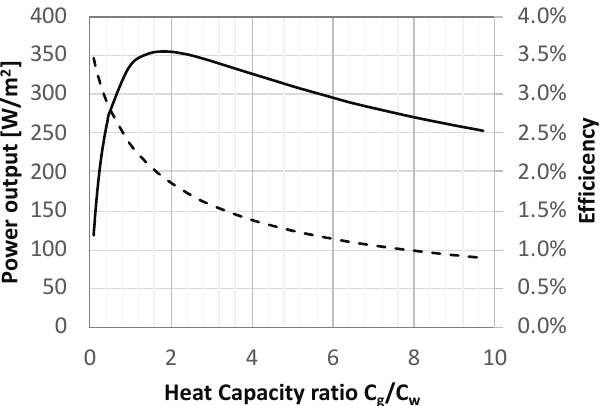
11 of 17 Figure 7. Energy harvesting efficiency as a function of heat capacity ratio, with a constant flow rate for water of 𝐶 (cid:3050) = 0.05 kg/s per unit footprint (1 m 2 ). This figure shows the maximum harvesting potential through the CHP system. TE output represents the electrical power output and 𝑄 repre-